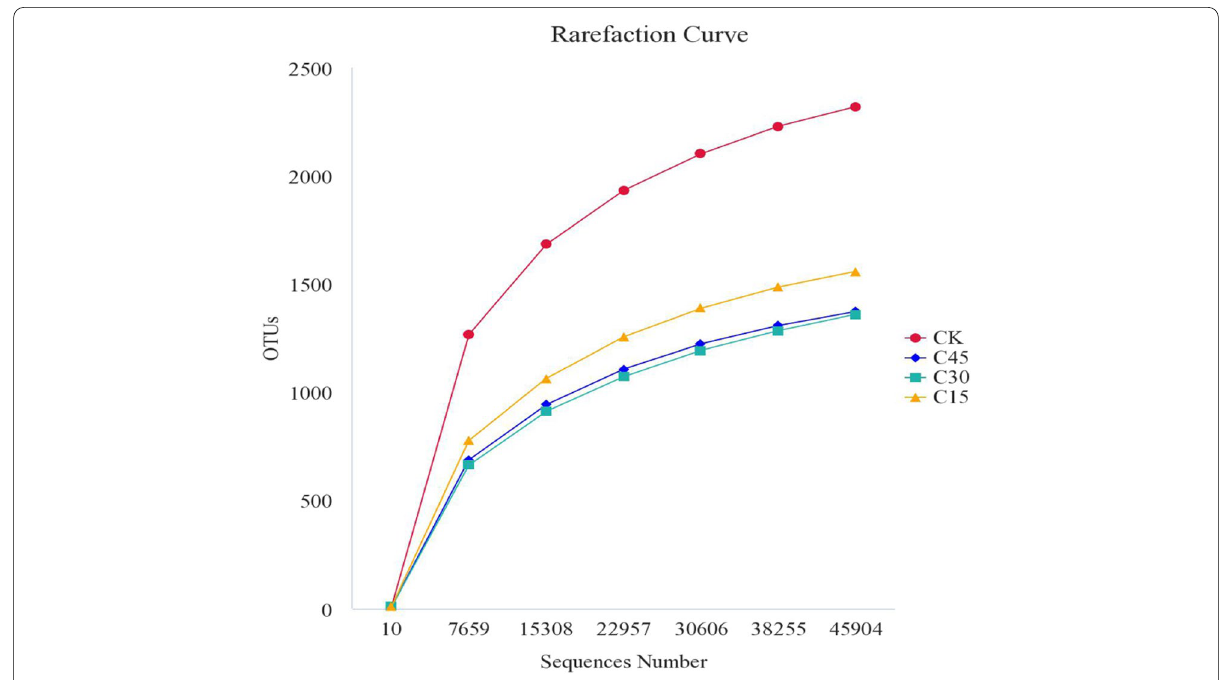
Fig. 2 Dilution curves of soil microorganisms under different oil pollution concentrations